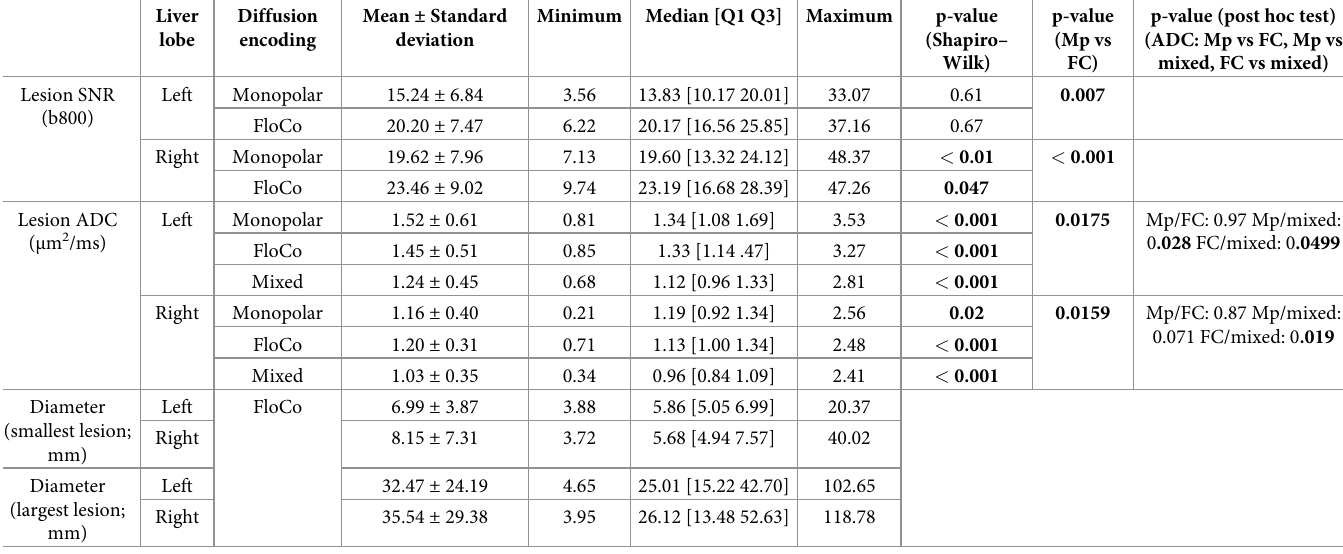
Table 3. Descriptive statistics of the quantitative lesion